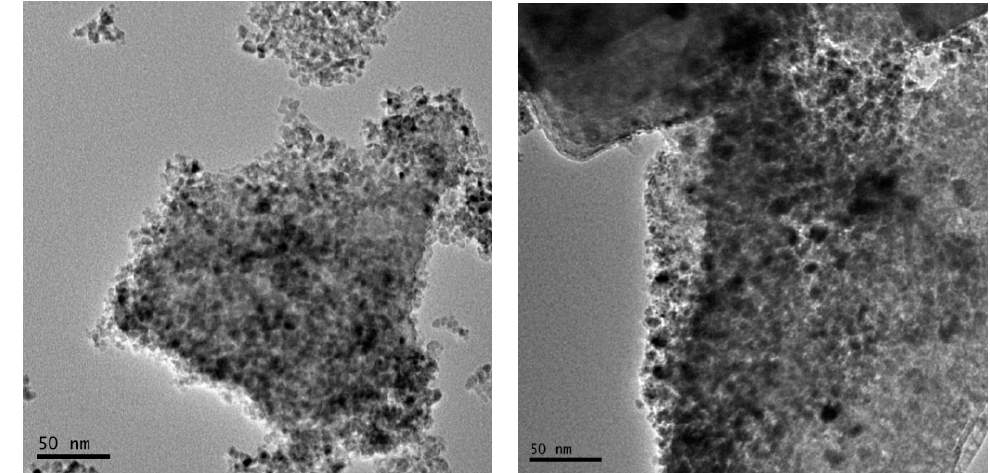
Figure 6. Transmission electron micrograph of Ni/HZSM-5 ( left ) and Ni/HZSM-5-1 ( right ) catalysts. Table 2. Physicochemical properties of Ni catalysts supported over parent HZSM-5 and the hierarchical HZSM-5 treated with different concentrations of NaOH solution (0.1–1.5 M) at 343 K for 1